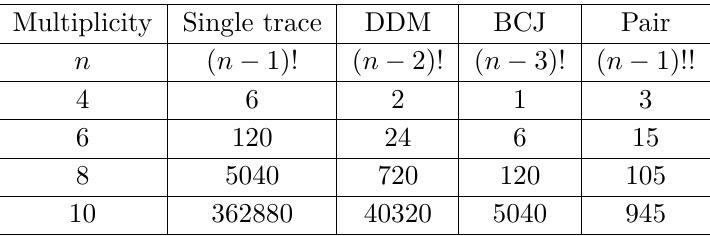
Table 1 . The size of different amplitude bases for